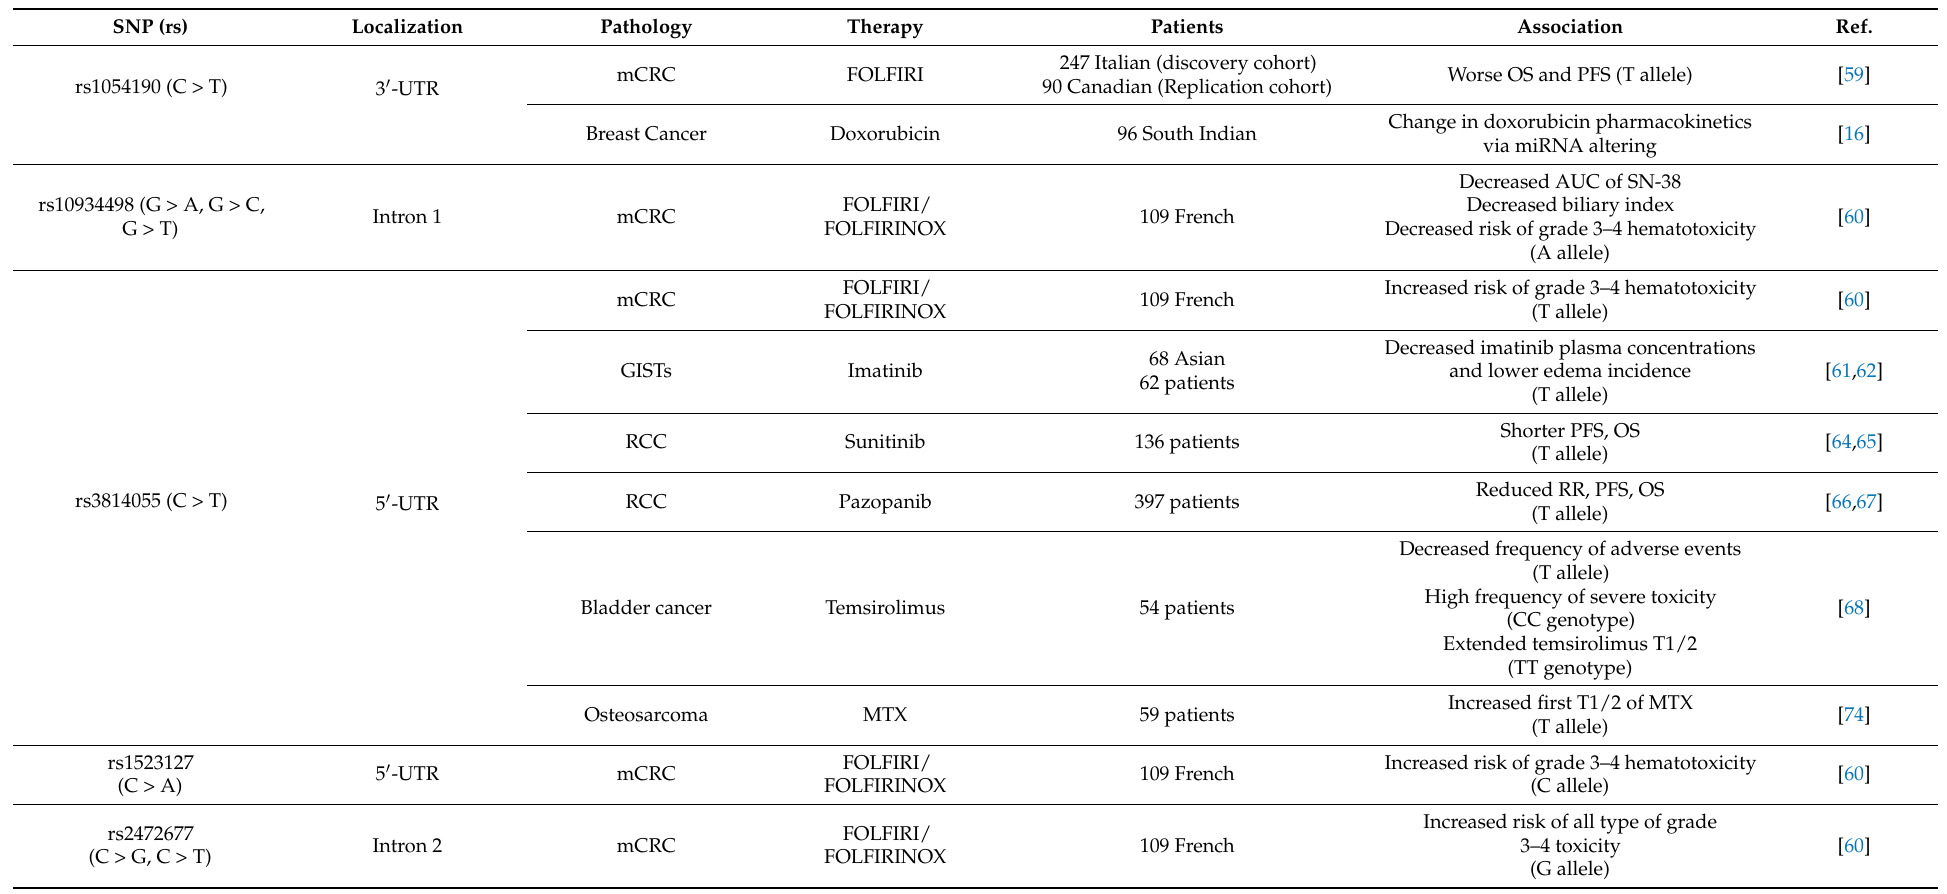
Table 1. PXR polymorphisms and their associations with efficacy, toxicity and pharmacokinetics of chemotherapeutic